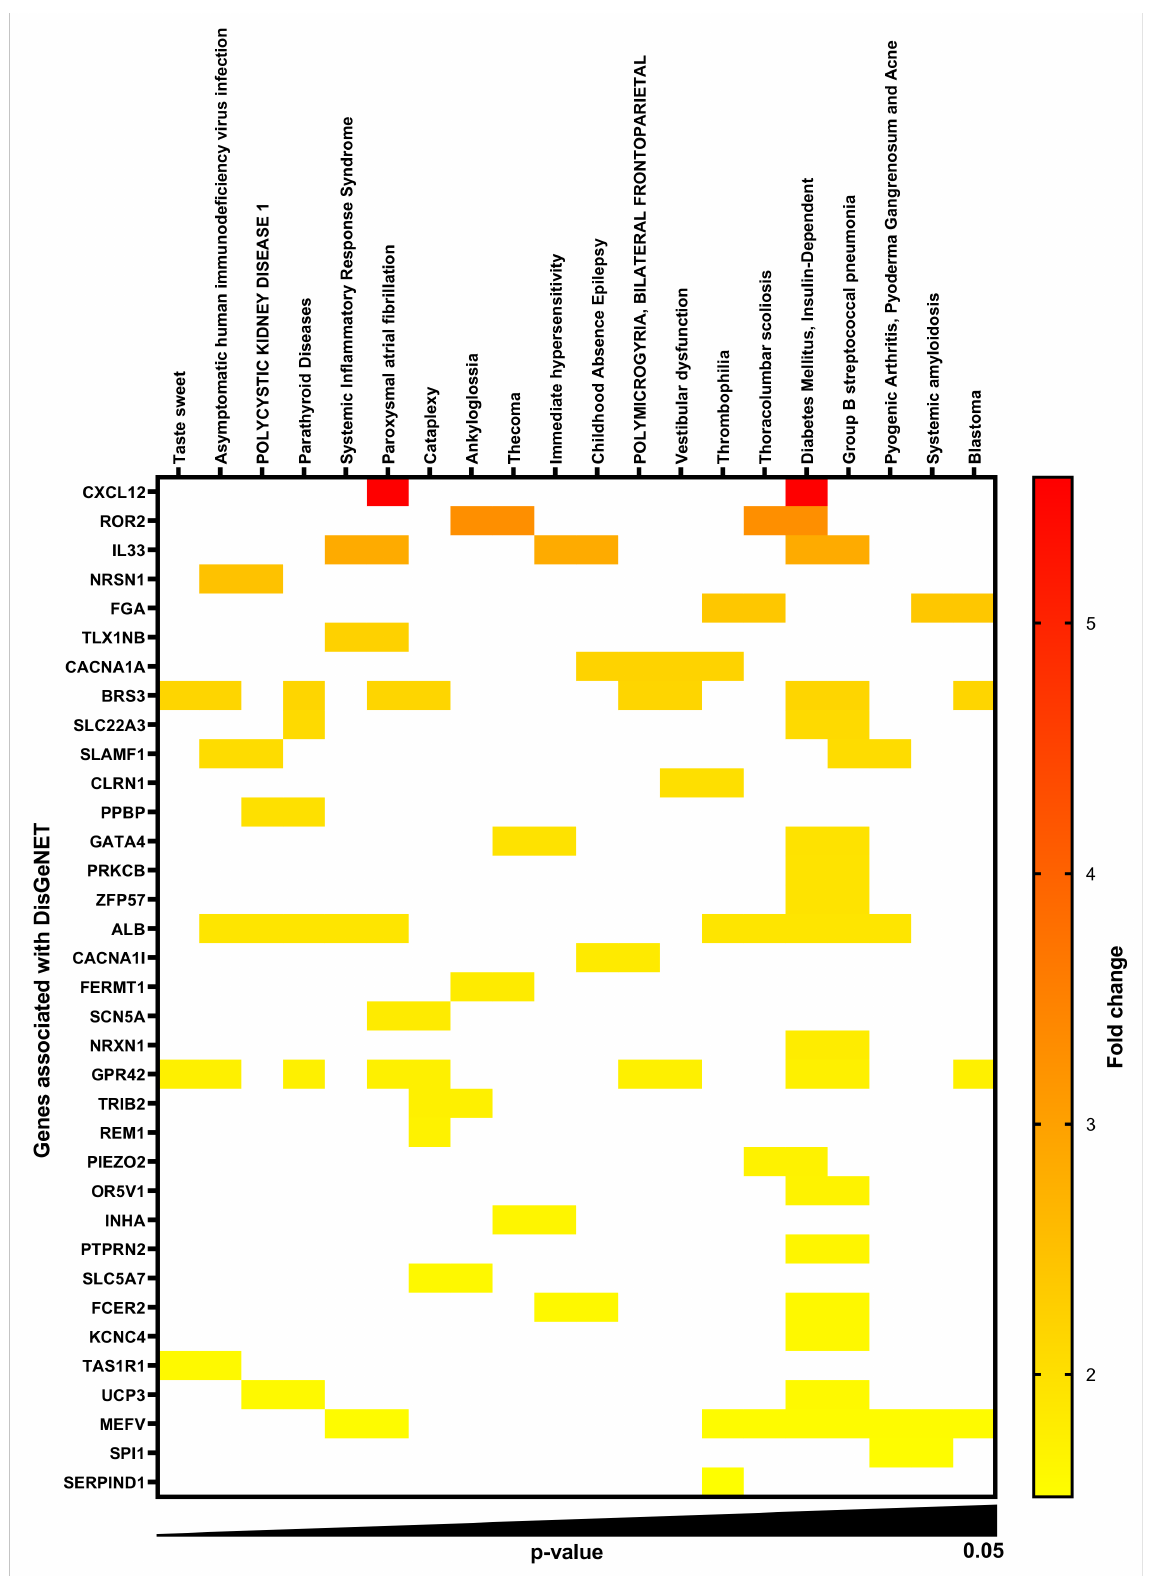
Figure 2. TMAO-upregulated genes in proximal tubular cells with DisGeNET association. Heat map showing the gene-disease association ( p < 0.05) profile of 35 significantly upregulated genes (fold change ≥ 1.5) in proximal tubular cells after 6 h of TMAO 300 µ M stimulation compared to unstimulated cells. Rows represent genes and columns represent DisGeNET